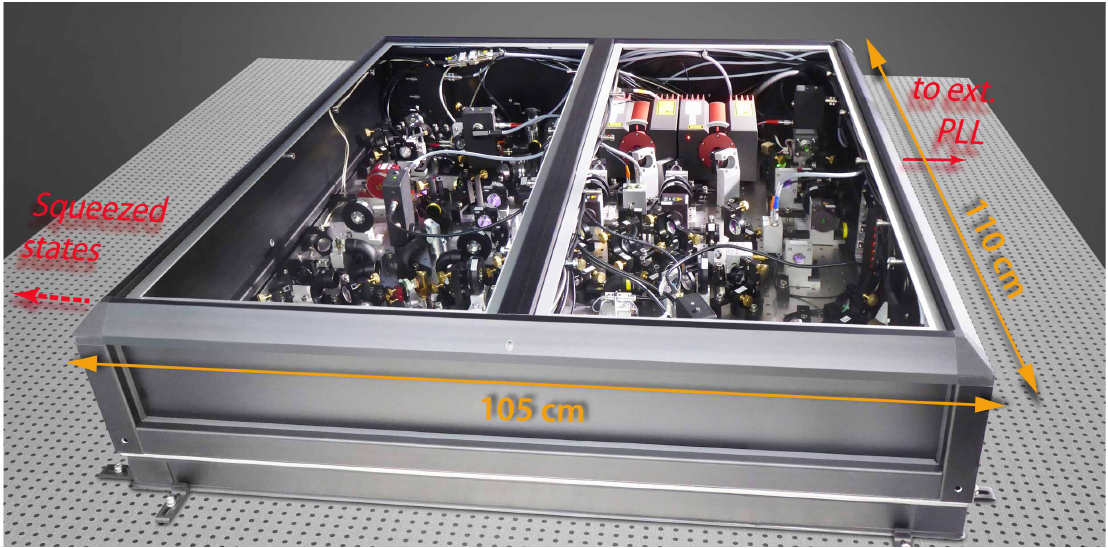
Figure 1. Picture of the squeezed light source on an optical table. The squeezed light source has two output ports to deliver the squeezed states and the tap-off for an external phase locking loop (PLL), respectively.